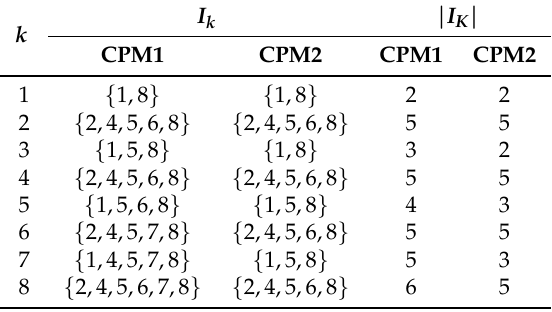
Table 1. Comparison of I k of the combination projection method (CPM) 1 and CPM2.